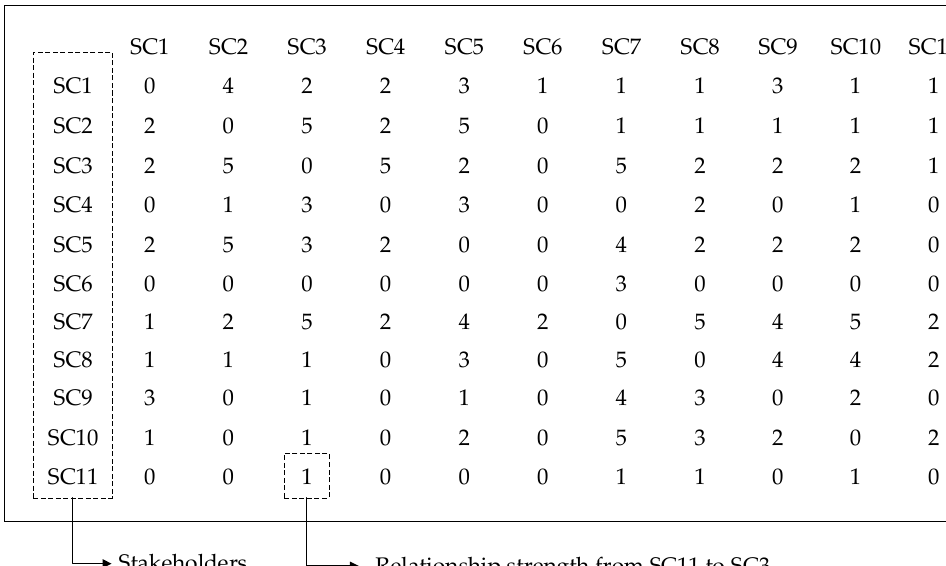
Figure 2. Directed matrix of the relationships among stakeholders.